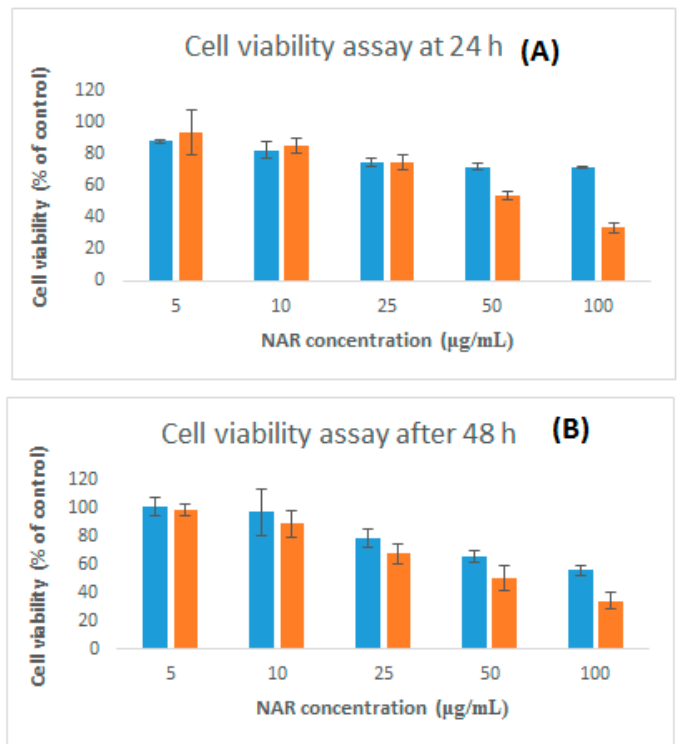
Figure 7. Dose and time dependent in vitro cytotoxicity of free NAR and NAR NPs on SH-SY5Y cells using MTT assay. Cell viability assay at 24 h ( A ) and 48 h ( B ). Control consisted of cells treated with 0.1% DMSO (vehicle control, 100 % cell viable). Values are expressed as mean ± SD ( n = 3), three independent experiments performed in triplicate.